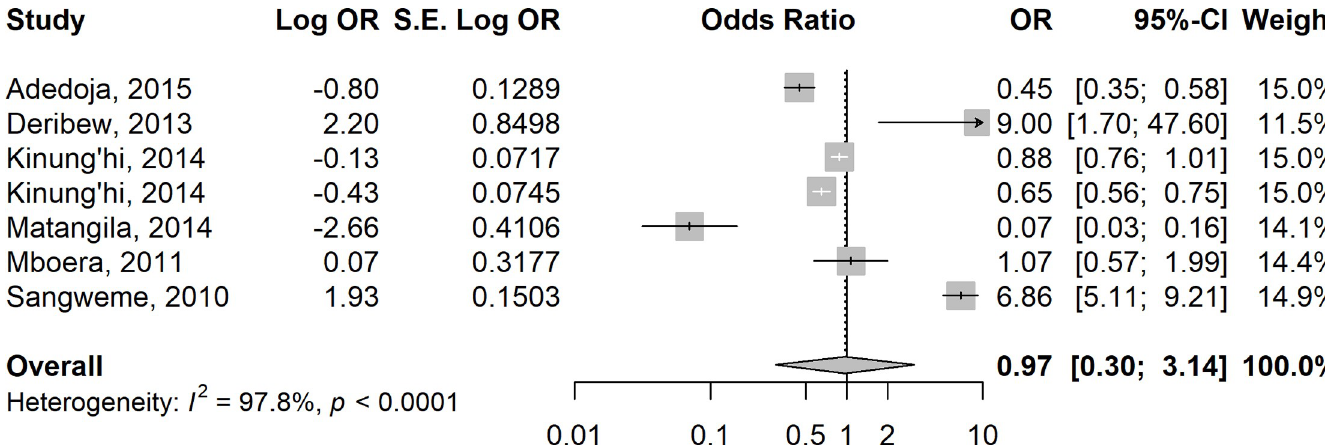
Fig 7. Forest plot showing odds of anaemia in children co-infected with Plasmodium species and pooled Schistosoma spp compared with those who were infected with P. falciparum alone.